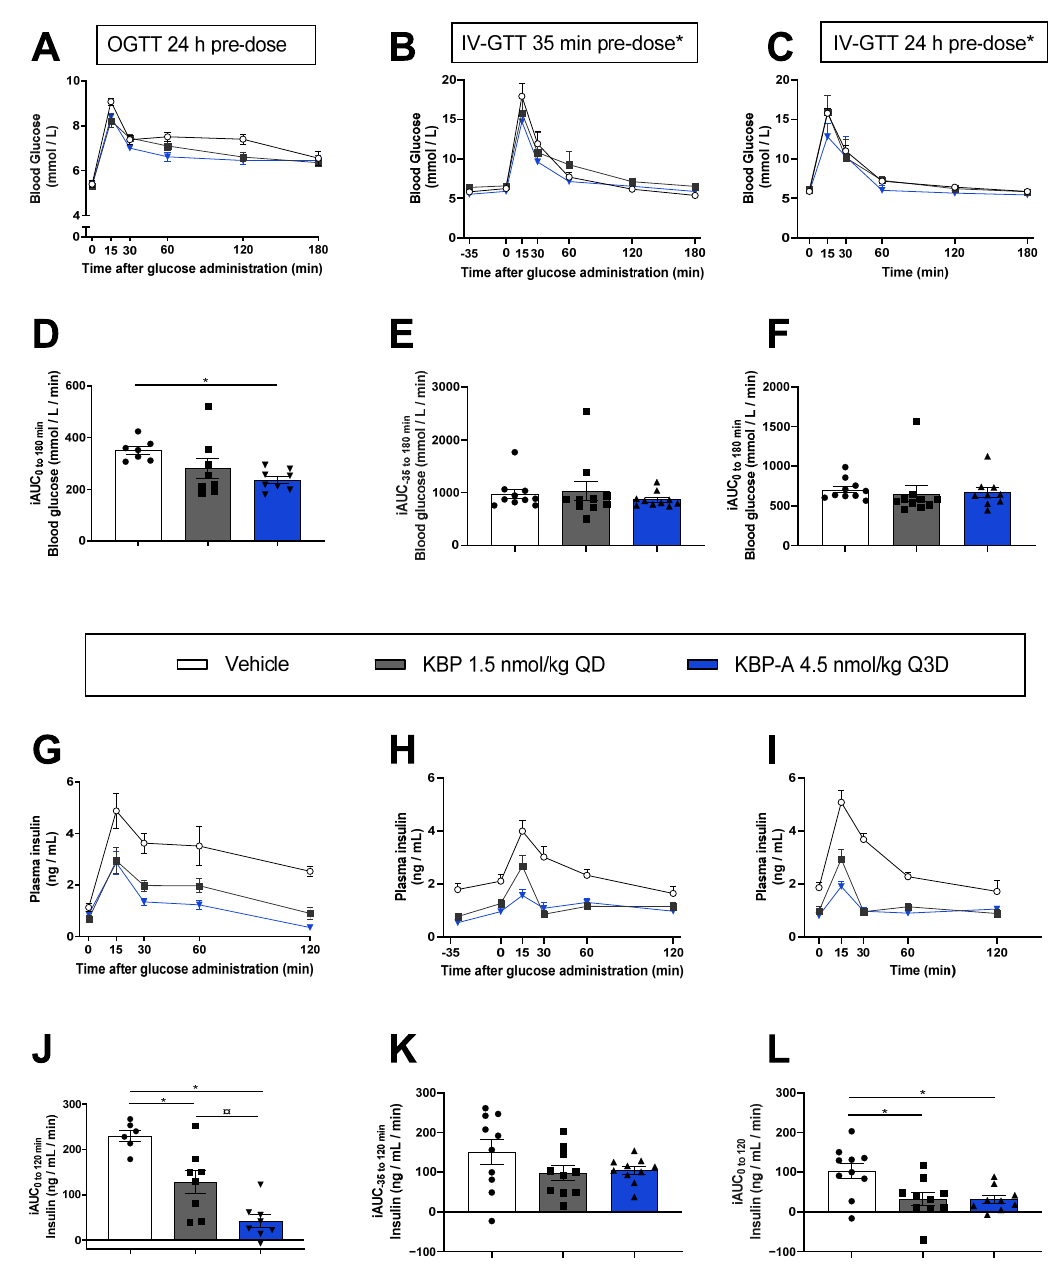
Figure 5. Assessment of glucose tolerance in overnight fasted (16 h) HFD Sprague–Dawley rats treated with saline (vehicle), KBP dosed once daily (1.5 nmol/kg QD), KBP-A dosed every 3rd day (4.5 nmol/kg Q3D). Three tests were performed: an OGTT ( A , D , G , J ) and two IV-GTT performed following 8 weeks, 3 or 5 weeks of treatment, where the last dose was s.c. injected 24 h, 35 min ( B , E , H , K ), or 24 h ( C , F , I ,L) prior to the glucose challenge. The OGTT was performed in one study, while the two IV-GTT were performed in other rats in a separate study. Graphs ( A , B , C ) show glucose levels during the tests and the calculated incremental area under the curves (iAUC) ( D , E , F ), while graphs ( G , H , I ) show plasma insulin levels during the tests and the calculated iAUCs ( J , K , L ). Pre-dose *: Rats receiving KBP were dosed with 4.5 nmol/kg, not 1.5 nmol/kg, prior to the IV-GTT to ensure that the results were not affected by acute dose differences. Pre-dosing 35 min favored the rapid plasma peak of KBP and 24 h pre-dosing favored the slow plasma peak of KBP-A. n = 8/group in the OGTT except for the vehicle where n = 7. n = 8/group in the 35 min pre-dose IV-GTT. n = 8/group in the 24 h pre-dose IV-GTT, except in the KBP-A group where n = 7. Statistical analysis of ( D , J , K , L ) were performed with one-way ANOVA and Tukey’s multiple comparisons test, and ( E , F ) were